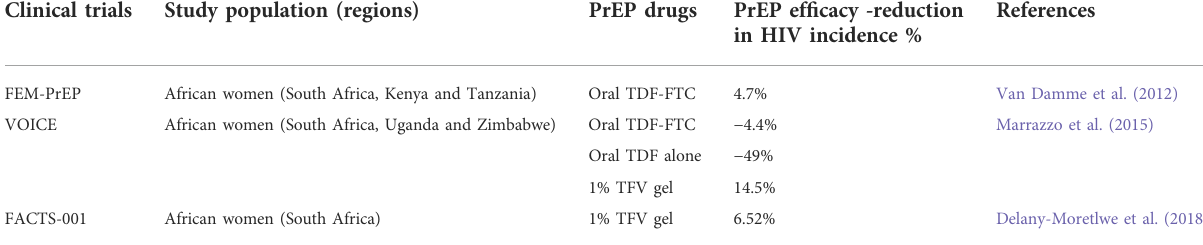
TABLE 2 PrEP clinical trials demonstrating low PrEP ef fi cacies in high-risk populations from different